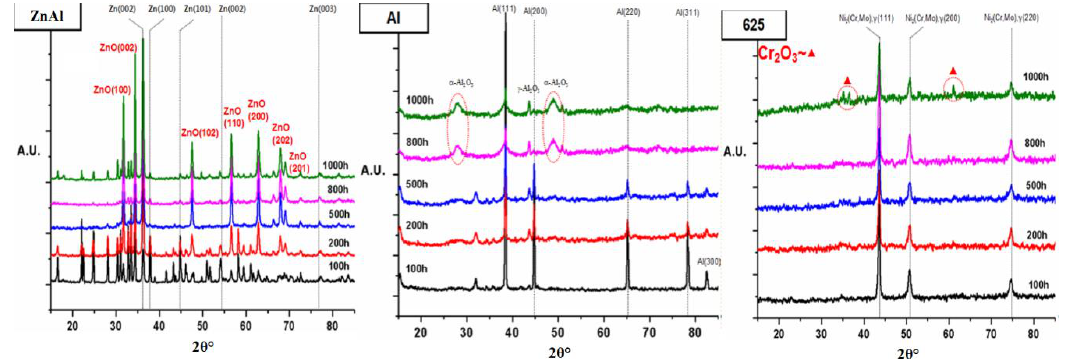
Figure 7. XRD spectra of the thermal spray coatings with NaCl deposition and controlled environmental corrosion: ( a ) ZnAl; ( b ) Al; ( c ) Inconel 625